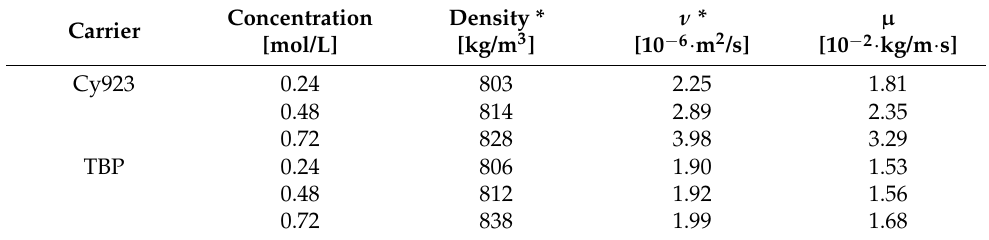
Table 5. Physical properties of different organic solutions which contains TBP diluted in kerosene. Concentration Carrier [mol/L]